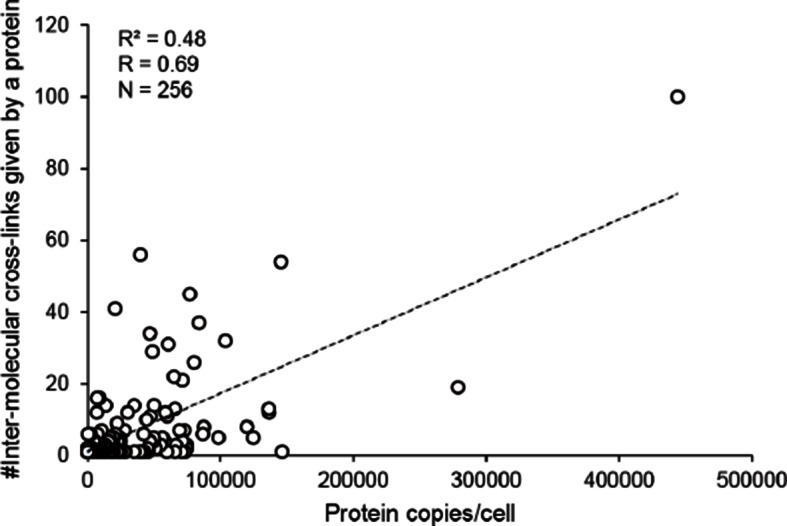
The number of inter-molecular cross-links observed for a protein in E. coli whole-cell lysates is positively correlated with the abundance of this protein.R, Pearson correlation coefficients; N, number of values.